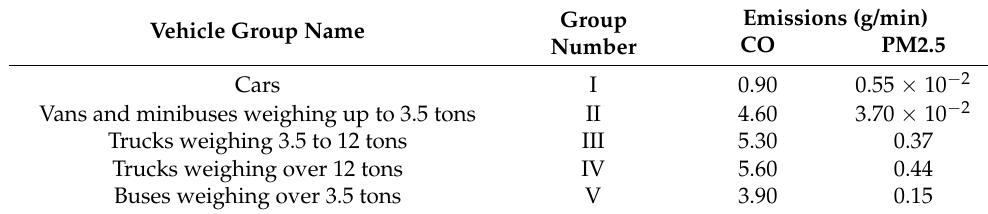
Table 3. Specific running exhaust emissions of the i -th vehicle-related pollutant [58].